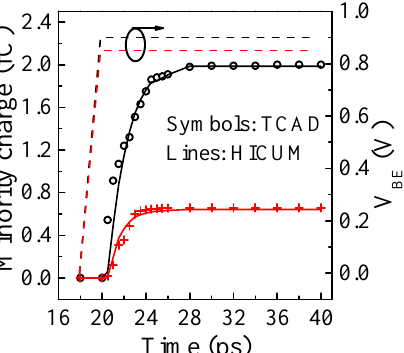
Figure 12. Time dependent turn-on stored minority charge (in the emitter and base): comparison between TCAD (symbols) and HICUM (solid line with alqf = 1) for the 0.09 µ m × 4.8 µ m SiGe HBT biased at V BE = 0.9 V (circle) and V BE = 0.85 V (plus), V BC = 0 V. V BEs ( t ) have been shown as a dashed line to the right Y